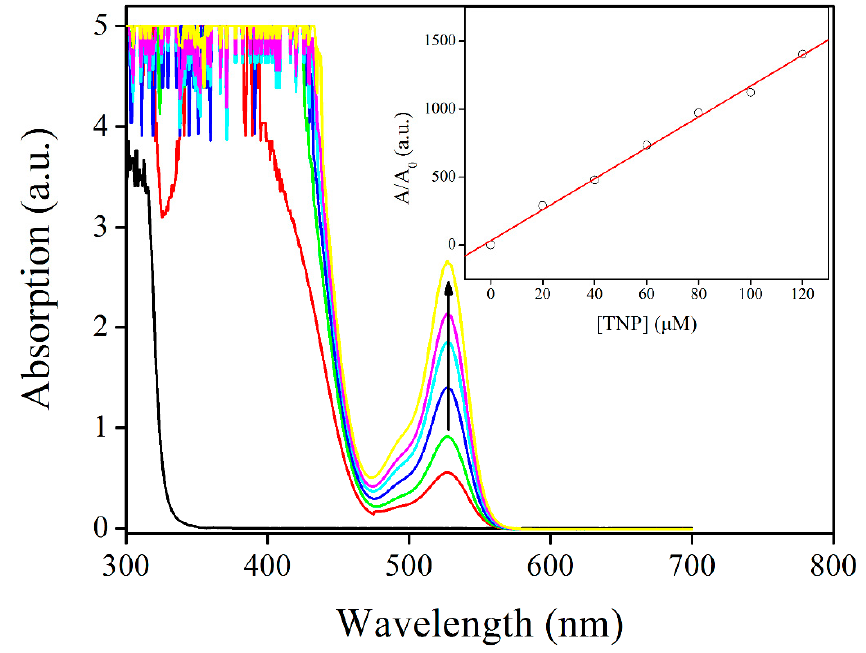
Figure 6. Absorption spectra of RS6h@EuBTC suspension in ethanol (0.1 mg / mL) under TNP concentrations from 0 to 120 µ M (interval = 20 µ M). Inset: A / A 0 against TNP concentration. Mean value of three test cycles was used for each data point.